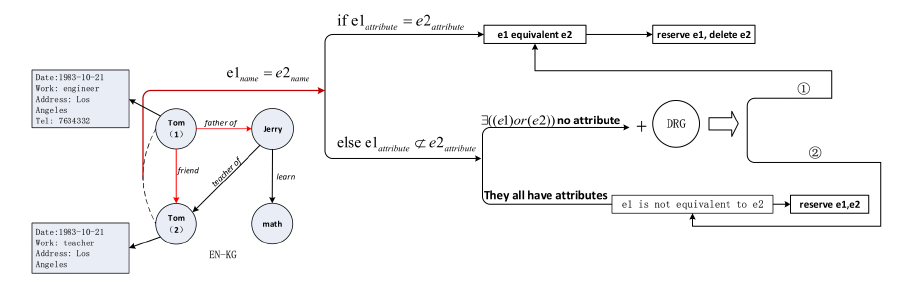
Figure 7. Entity screening rule.